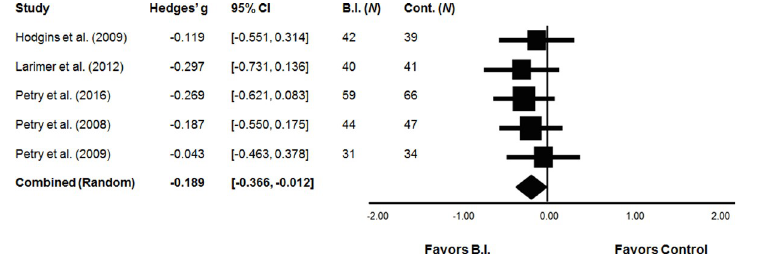
Fig 2. Efficacy of brief interventions vs. assessment only control